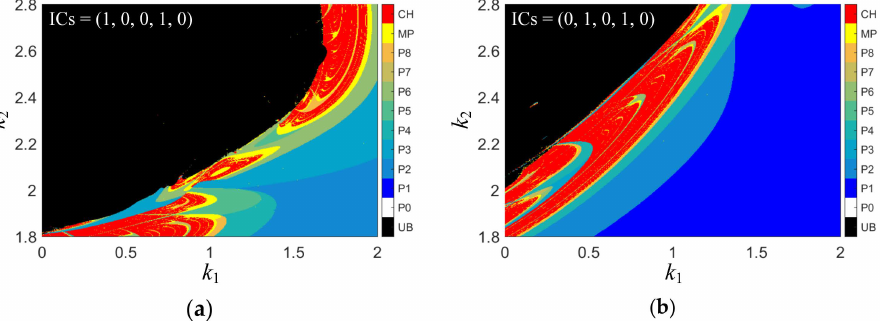
Figure 3. Two-parameter bifurcation diagrams in the k 1 – k 2 plane for two sets of different initial conditions: ( a ) ICs = (1, 0, 0, 1, 0), and ( b ) ICs = (0, 1, 0, 1,